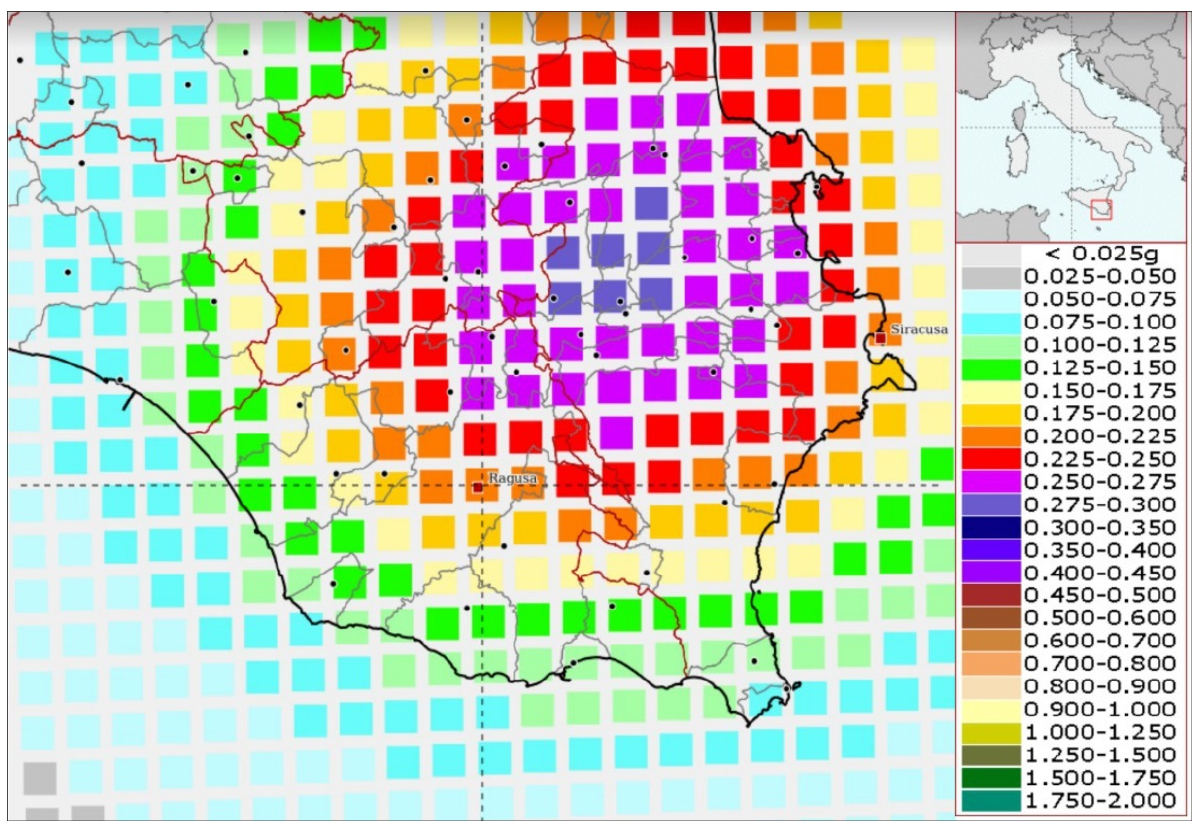
Figure 3. Interactive seismic hazard maps of the city of Ragusa with 10% probability of exceedance in 50 years (return period of 475 years), PGA = 0.200–0.225 g.